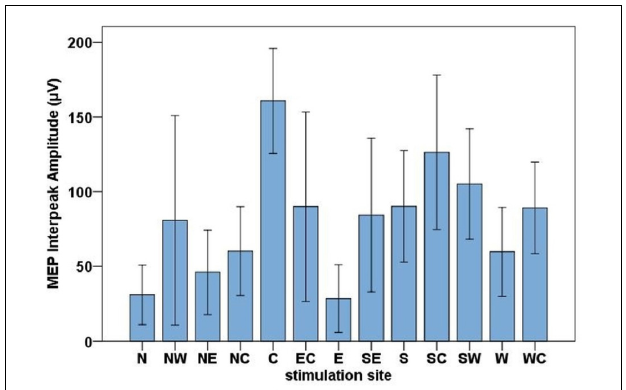
FIGURE 6 | Bar chart of the mean MEP interpeak amplitudes for all stimulation sites (North, North-West, North-East, North-Central, Central,